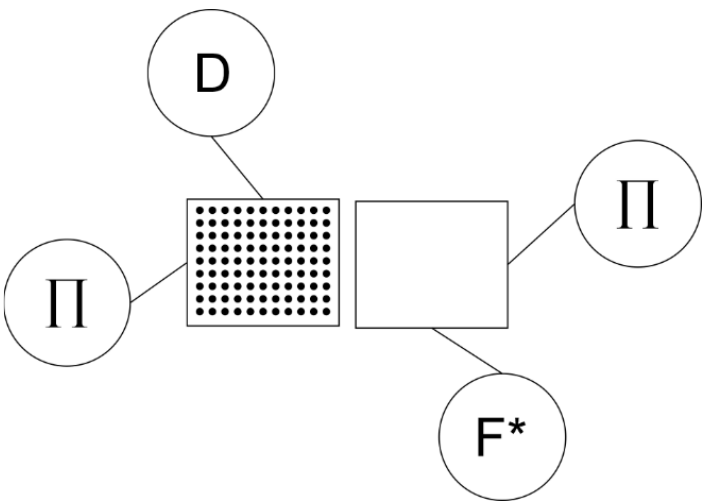
Figure 3. The apical pole of the D-cell with the two fractions of its surface for D-Function and F*-Function.